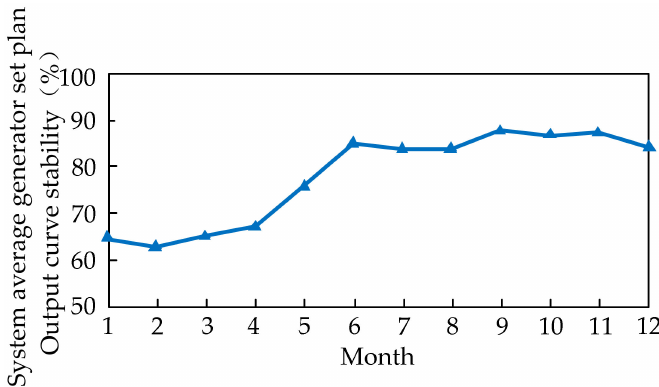
Figure 7. The stability of the output curve of a system thermal power